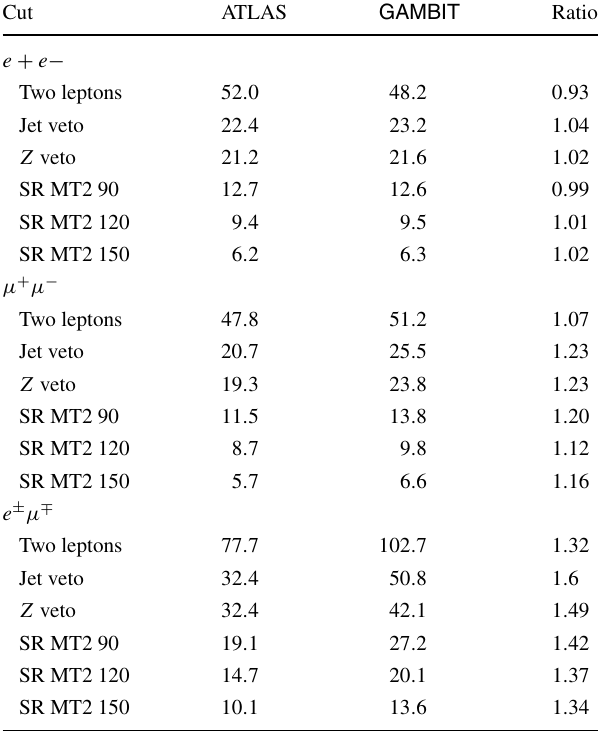
Table 5 The published ATLAS cutflow for Model 1 in Ref. [46], a searchfornewphysicsineventswithtwoleptonsandmissingtransverse momentum.Thisiscomparedwiththe GAMBIT cutflowobtainedusing Pythia8 and BuckFast . Shown are the numbers of events expected in 20.1 fb − 1 of 8 TeV ATLAS data, and the ratio of the GAMBIT and the ATLAS cutflow (and thus our cutflow does not include the effect of the LO cross-section that we use in our SUSY scans)